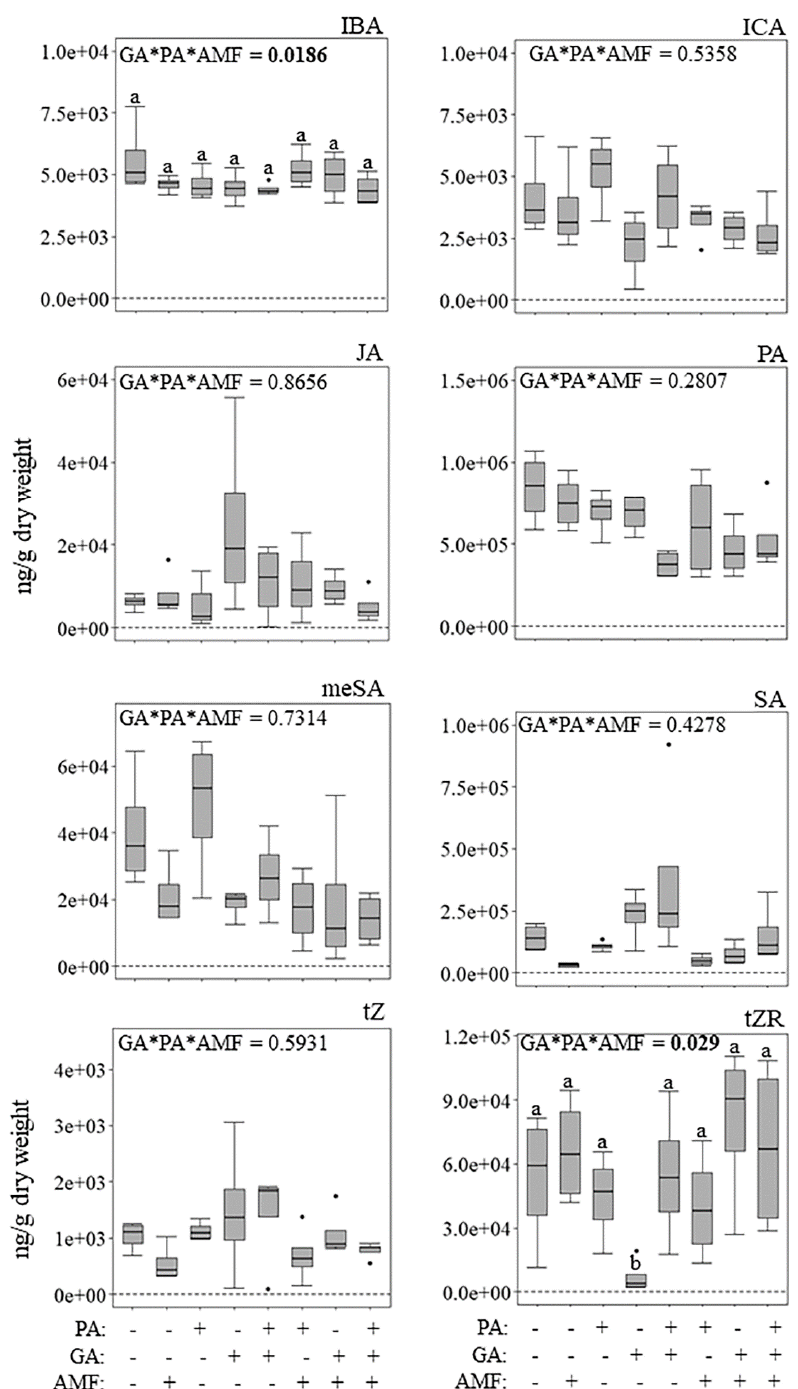
Figure 2. Impact of exogenous gibberellic acid (GA) application, 36 h of pea aphid ( Acyrthosiphon pisum ) (PA) feeding, and AM fungus ( Rhizophagus intraradices ) (AMF) root colonization on phyto- hormone concentration in lamina and petiole tissue. Potted plants were grown in topsoil: sand mix for 44 days. Plants were harvested at 51 days post seed sterilization. Three-factor analysis using gamma distribution was used. Values represent the mean ± SEM ( n = 4). Different let- ters represent significant differences among groups using Tukey–Kramer post hoc tests ( p < 0.05). ABA = abscisic acid; DPA = dihydrophaseic acid; IAA = indole-3-acetic acid; IA alanine = indole-3- acetyl alanine; IAcrA = indole-3-acrylic acid; IA nitrile = indole-3-acetonitrile; IBA = indole-3-butyric acid; ICA = indole-3-carboxylic acid; JA = jasmonic acid; PA = phaseic acid; mesa = methyl salicylate; SA = salicylic acid; tZ = trans -zeatin; tZR = trans -zeatin